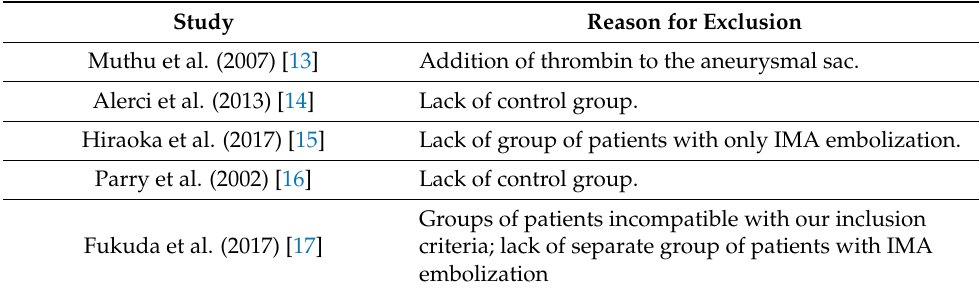
Table 2. Details of excluded studies after full-text analysis; IMA—inferior mesenteric artery. Study Reason for Exclusion Muthu et al. (2007)